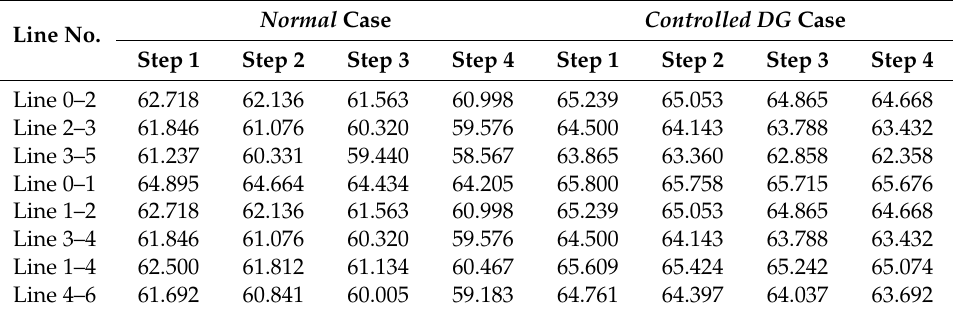
Table A6. Receiving voltage values of lines for all steps and both cases (kV). Line